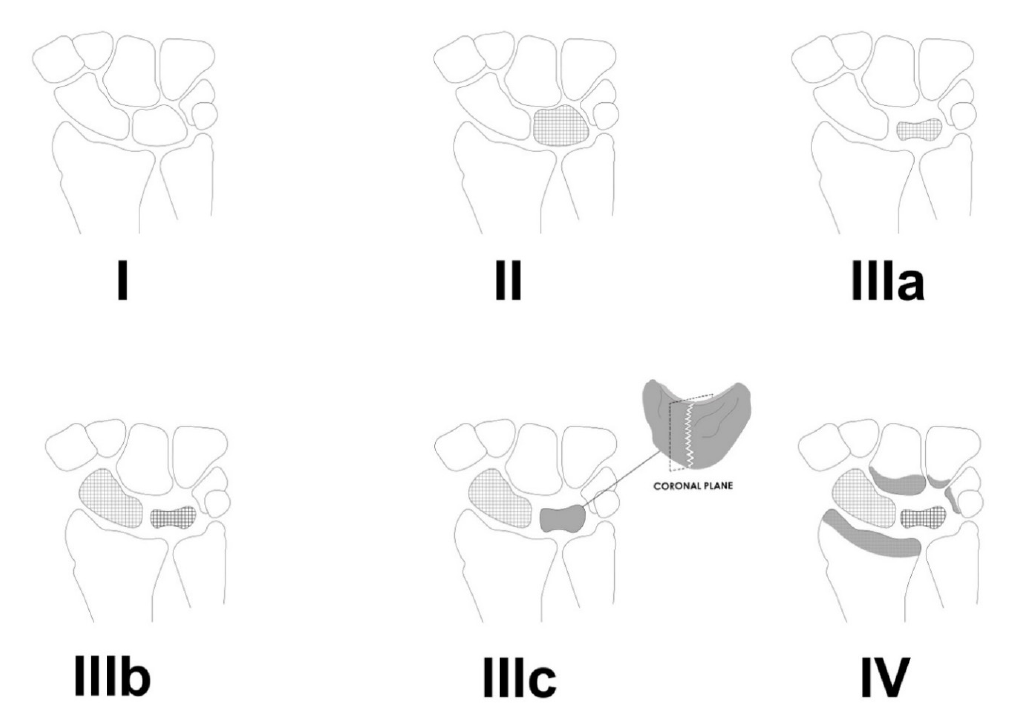
Figure 1. A graphic representation of different stages of Kienböck’s disease. In stage I lunate maintains normal architecture and density. Stage II is characterized by an increase in lunate density and diffused sclerosis of the lunate (visualized with a checkered pattern). In stage IIIa the lunate is collapsed but its carpal alignment and height remain unchanged (notice the decreased size of the lunate). In stage IIIb apart from lunate collapse, scaphoid palmar flexion occurs (visualized with a checkered pattern). Stage IIIc is reserved for complete coronal plane split (depicted as a bisection of the lunate). Stage IV is a combination of lunate collapse and radiocarpal or midcarpal degenerative arthritis (marked as grey areas on the articular surfaces of affected joints).